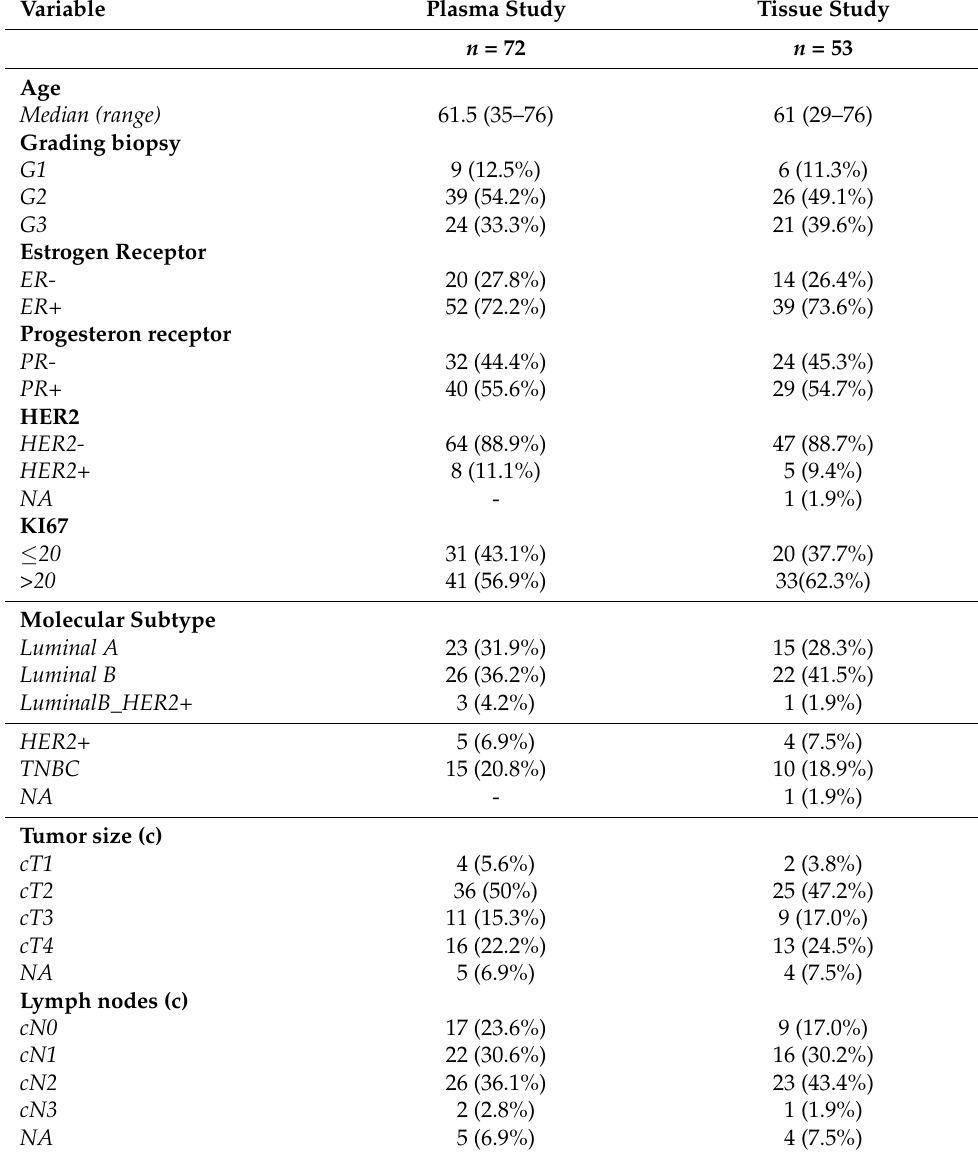
Table 1. Clinico-pathological data of the patients included in the